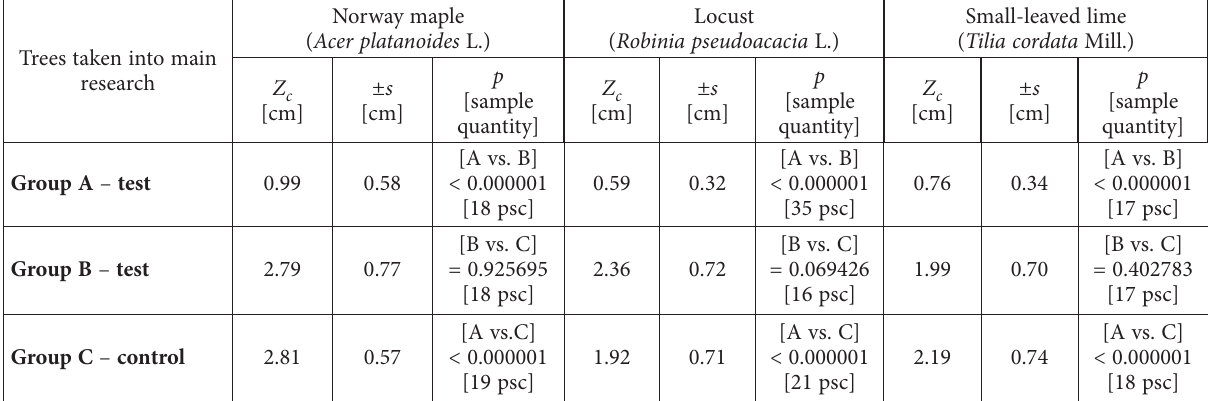
Table 1. The response of the mean yearly increment of trunks circumference at h = 1.3 m to the impact of earthworks due to park’s road system modernization for the three most abundant tree species in Ursynów and Królikarnia Parks in Warsaw Norway maple Locust ( Acer platanoides L.) ( Robinia pseudoacacia L.) Trees taken into main research